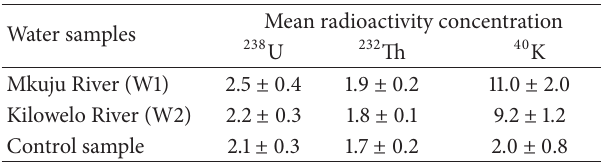
Figure 1: The average radioactivity concentrations values of water samples obtained in the present study compared with studies con- ducted elsewhere in the world. Table 4: The average activity concentration of radionuclides in the collected water samples (Bq/L ±